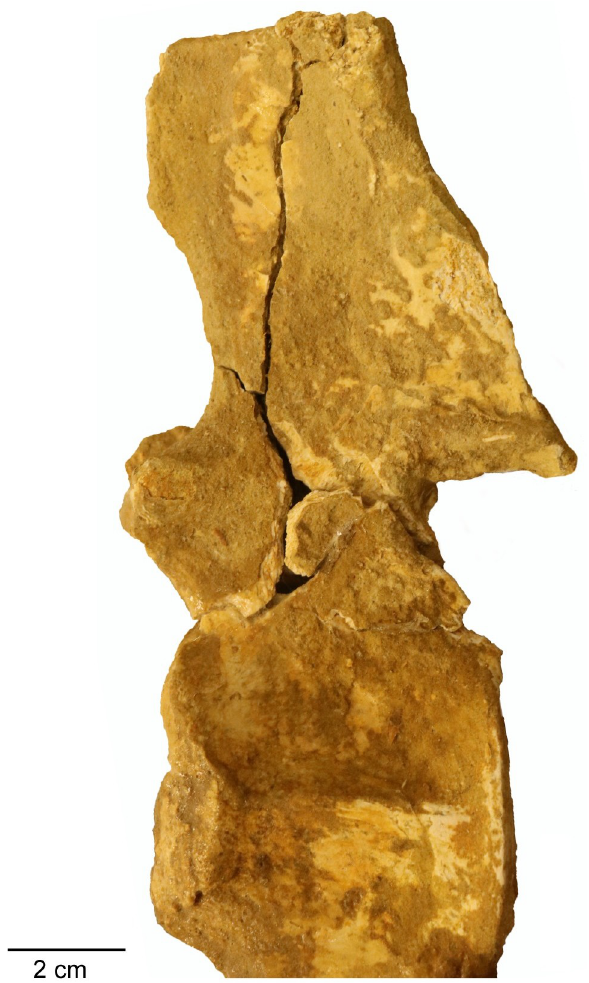
Fig 22. ‘Middle cervical vertebra b’ with neural spine from Cardiocorax mukulu (MGUAN PA278). The anterior margin of the neural spine exhibitsa sinusoidal outline.